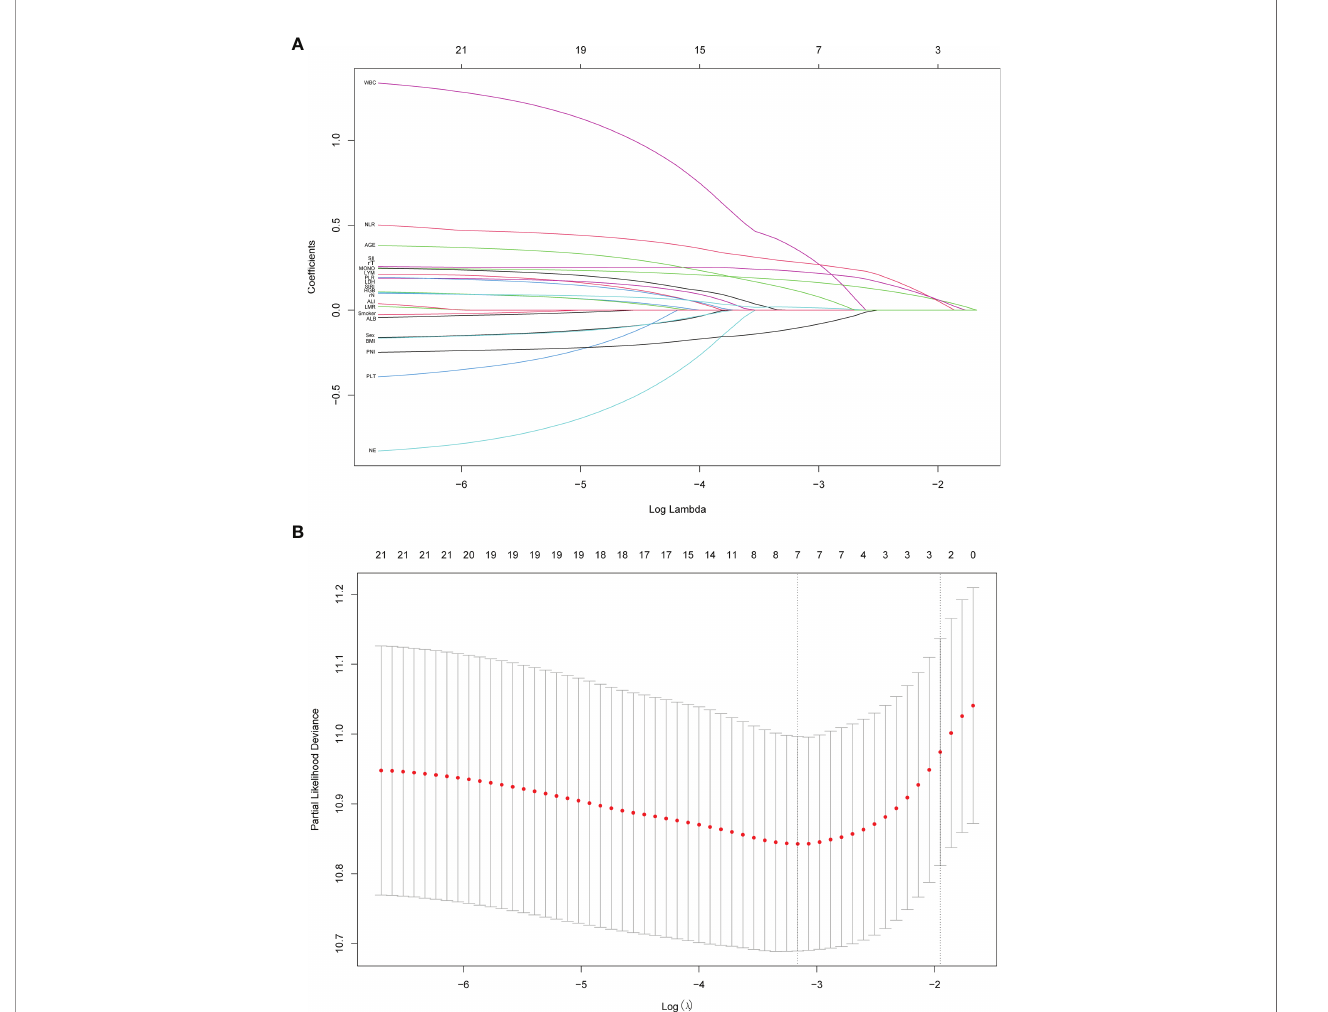
FIGURE 1 | Predictor variables selection using the least absolute shrinkage and selection operator (LASSO) binary cox regression model. (A) LASSO coef fi cient pro fi les of the 21 predictor variables. (B) Tuning parameter l selection in the LASSO model used fi vefold cross-validation. Dotted vertical lines were drawn at the optimal values by using the minimum criteria ( l .min) and the 1 standard error of the minimum criteria (the 1-SE criteria, l .1se). l .1se value of 0.142 was chosen and screened out three optimal predictors. The fi gures were created using R Studio software